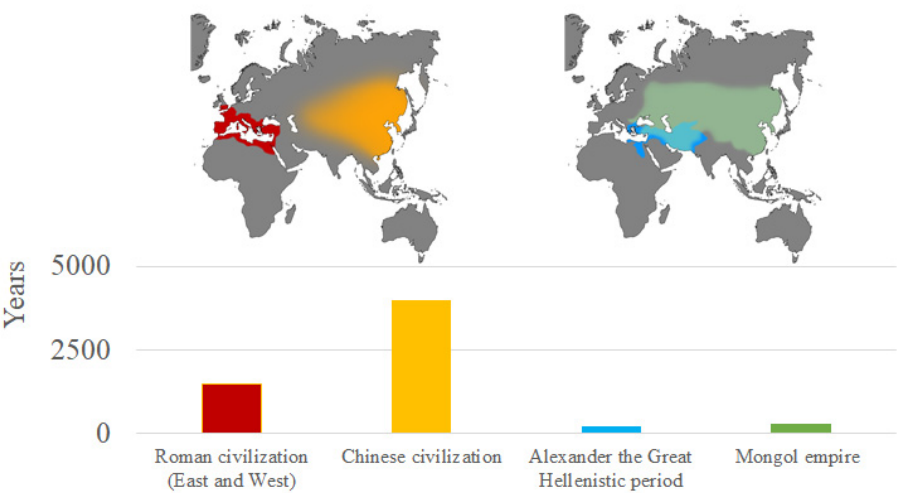
Figure 10. Roman, Chinese, Alexander the Great-Hellenistic Period, Mongols. ( Upper ): Expansion of civilizations; ( Lower ): Duration of civilization based on civil infrastructures (Roman, Chinese) and duration of civilization based on state-of-the-art military technologies (Alexander the Great- Hellenistic Period, Mongols). Geographical areas are delineated approximately.